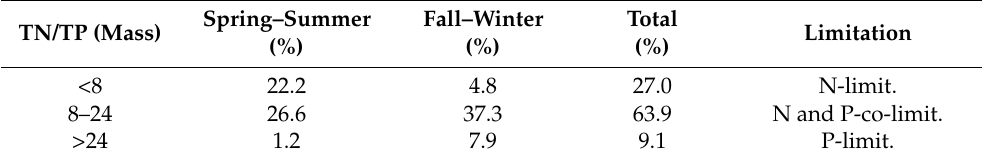
Figure 6. ( a ) Average TN:TP mass ratio per locations; ( b ) distribution of average monthly TN:TP mass ratio relative to N and P limitations in spring–summer (growing season) and fall–winter (non-growing season) periods, with dashed lines at particular (8 and 24) thresholds. Table 4. Seasonal distribution (%) values in different TN:TP ratio ranges.